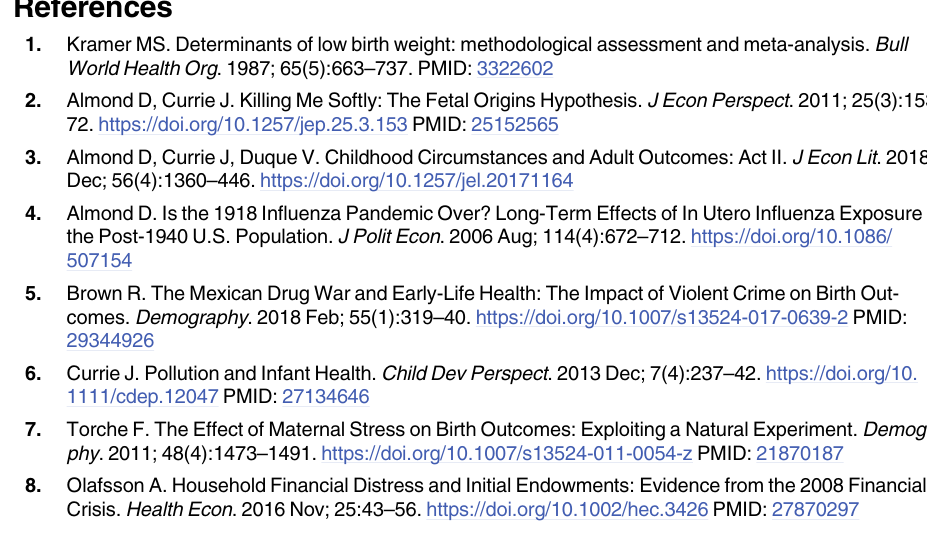
S1 Table. Extended version of Table 2. S2 Table. Extended version of Table 3. S3 Table. Extended version of Table 4. S4 Table. Extended version of Table 5. S5 Table. False discovery rate controlling